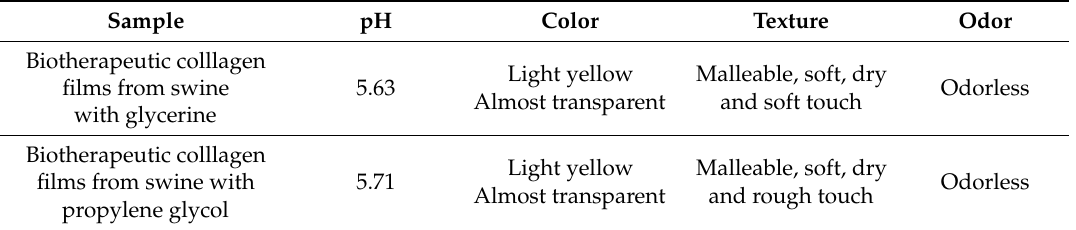
Figure 8. Films sample obtained from collagen of swine skin with: ( a ) glycerin and ( b ) propylene glycol. Table 11. Comparative organoleptic characteristic of biotherapeutic collagen films from swine.